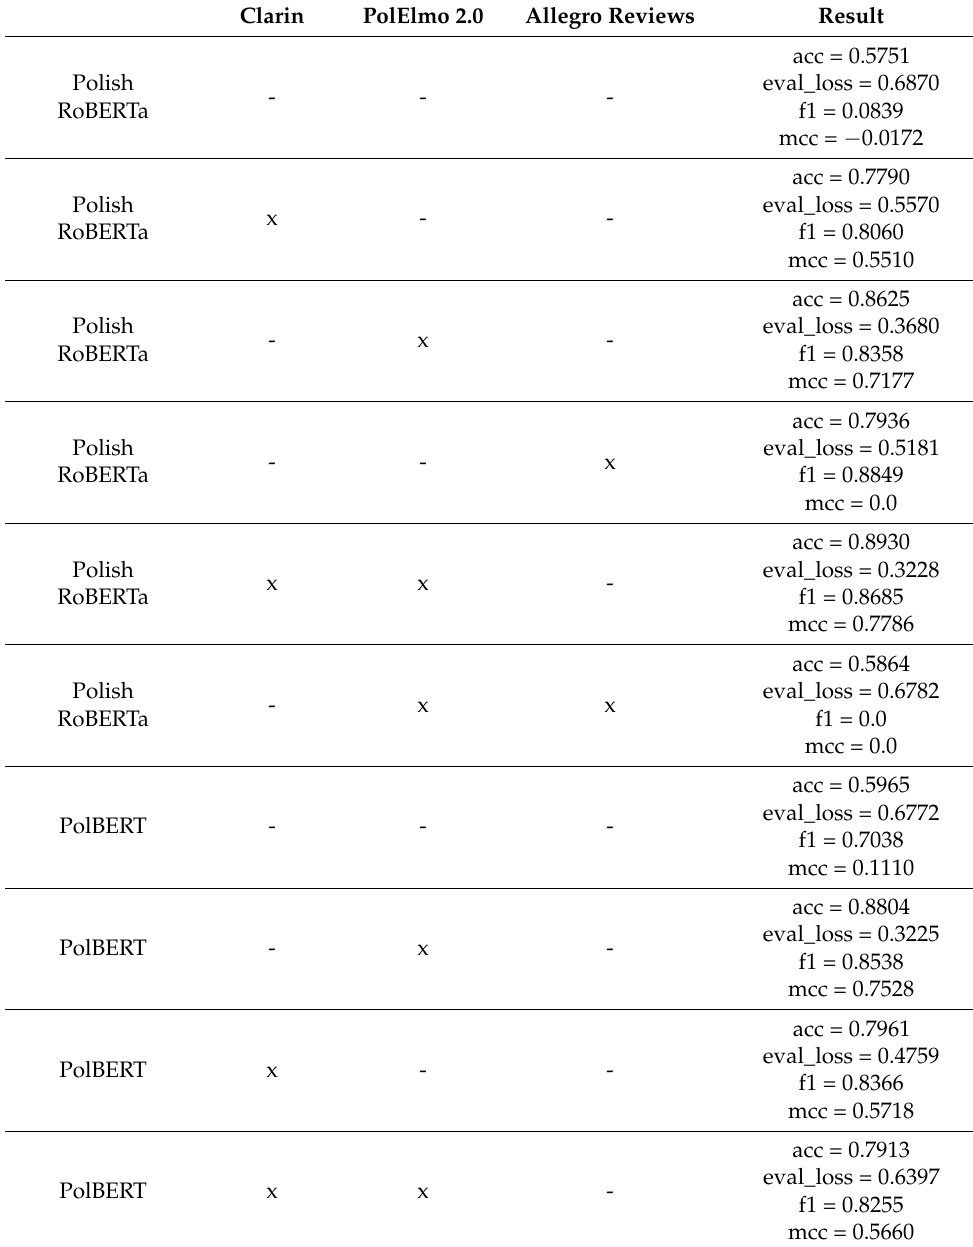
Table 3. Results of comparative experiments for Polish-language